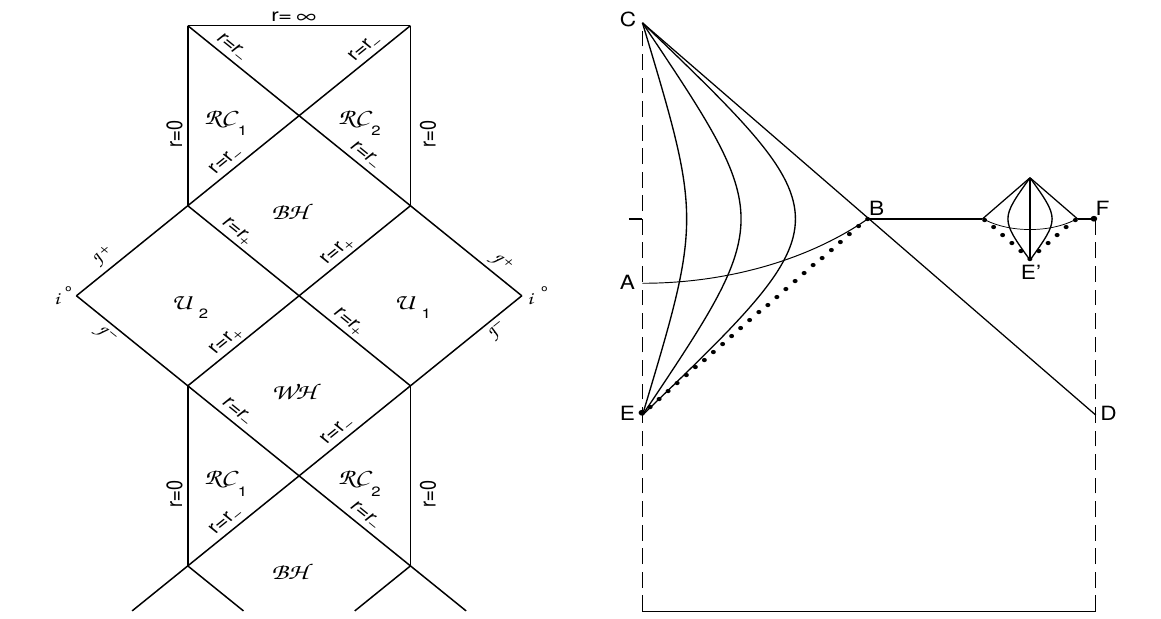
Figure 6. Left: Quantum birth of a closed universe inside a Λ BH [60]. Right: Penrose–Carter diagram [73] for the case of quantum birth of an open or flat